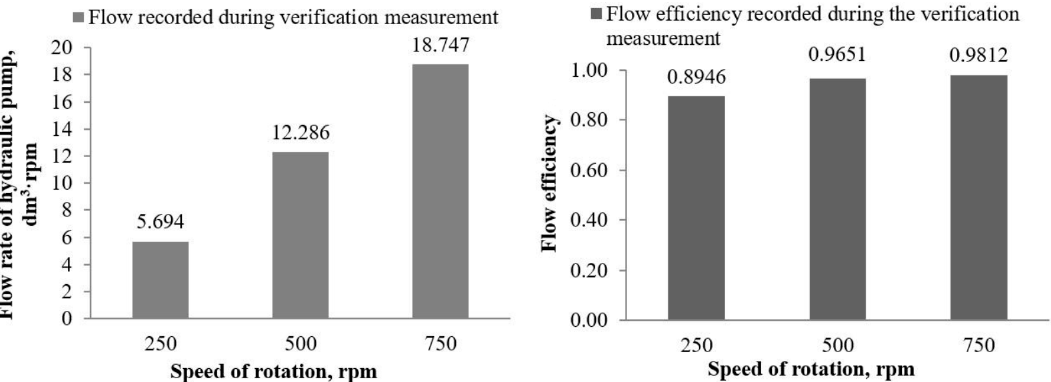
Figure 4. Hydrostatic transducer flow and flow efficiency values recorded during the measurements.